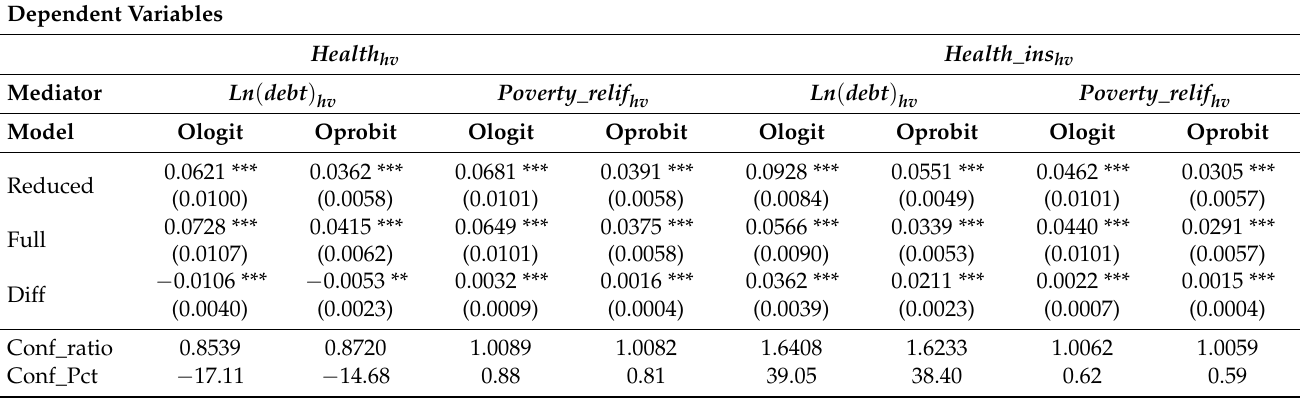
Table 8. Mediation effects of debt and poverty reduction in the microcredit–health